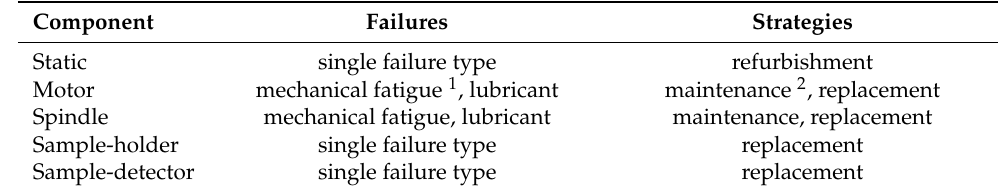
Table 9. Stops per component of the friction welding machine